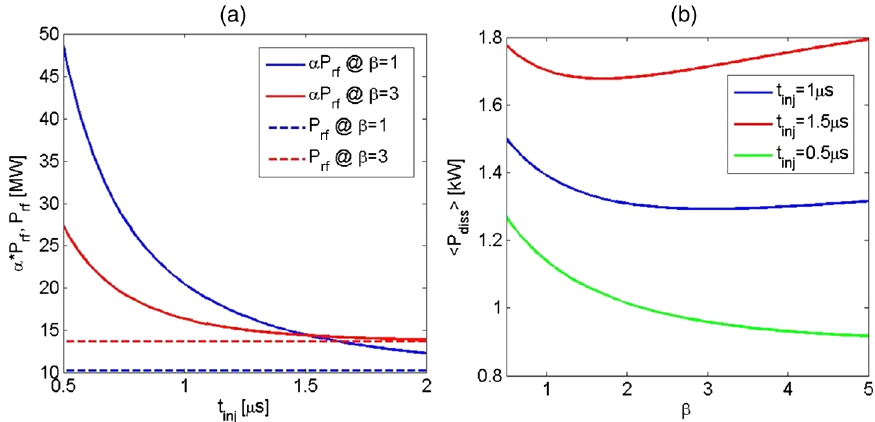
FIG. 5. (a) Peak input power as a function of the injection time for two different coupling coefficient; (b) average dissipated power as a function of the coupling coefficient for different injection times ( E